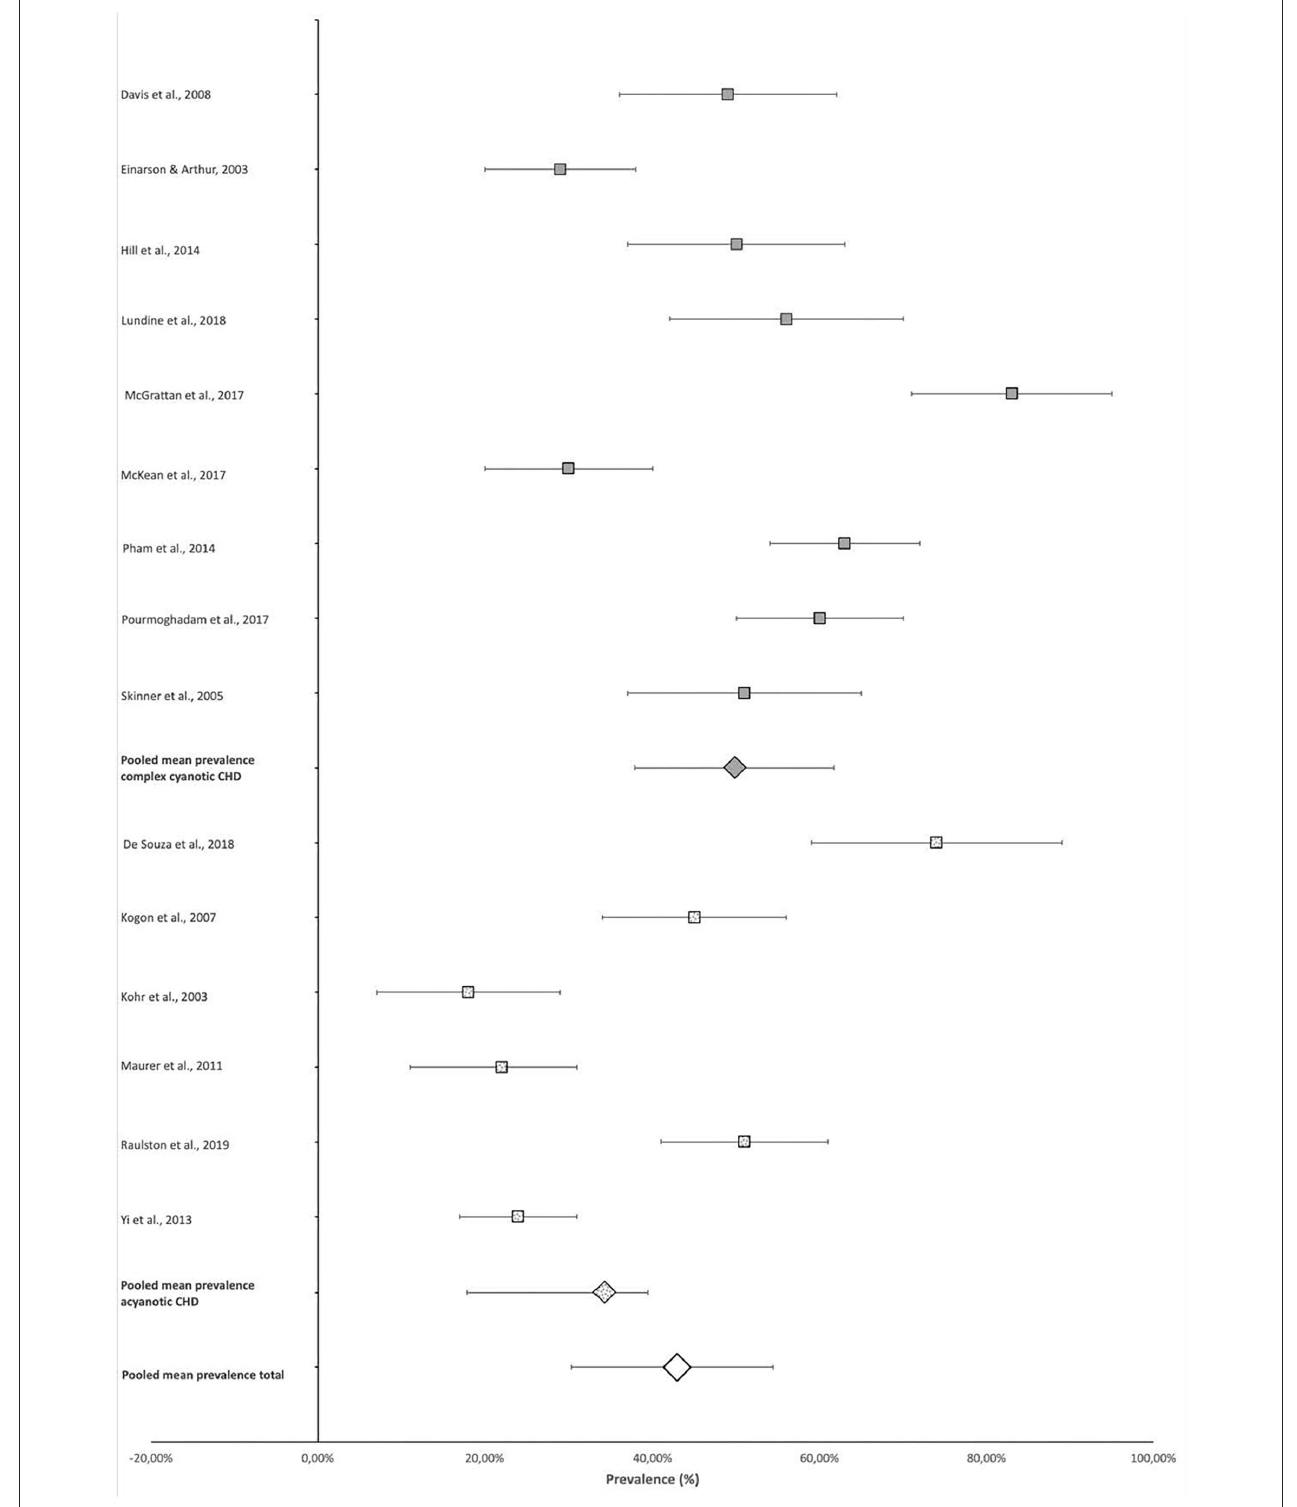
FIGURE 2 | Prevalence of feeding and swallowing